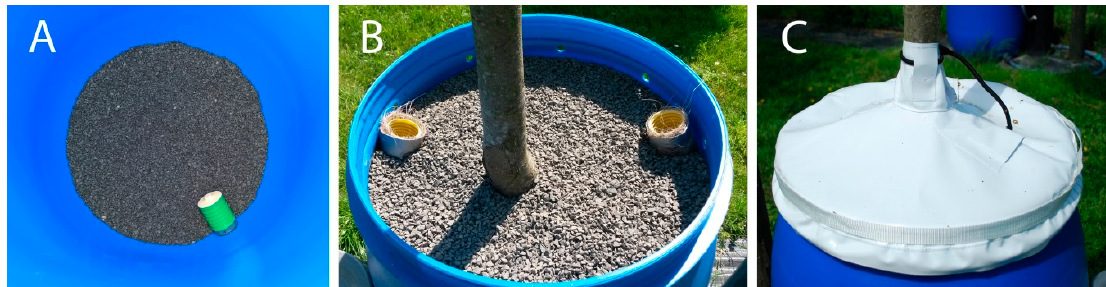
Figure 3. Plant container preparation. ( A ) Nozzle and gravel in the lower part of the container. After the picture was taken, more gravel was added until the nozzle was covered. ( B ) Gravel covering the soil surface. The ends of the drainage pipe as well as the ventilation holes near the rim of the container are visible. ( C ) Rain cape.